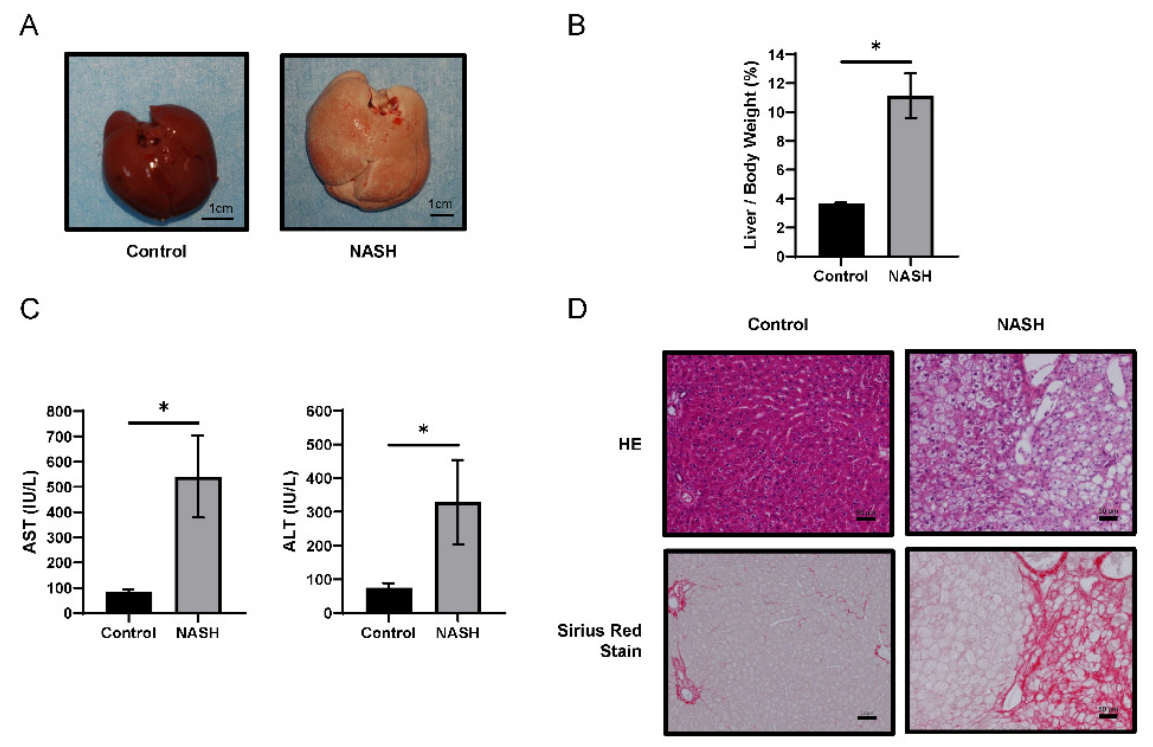
Figure 1. Comparison between SHRSP5/Dmcr rats fed a standard diet (SD) or high-fat and high- cholesterol (HFC) diet for 8 weeks. ( A ) Representative macroscopic appearance of control ( n = 4) and non-alcoholic steatohepatitis (NASH) ( n = 4) livers. Scale bars = 1 cm. ( B ) The liver-to-body weight ratio in each group. ( C ) Aspartate transaminase (AST) and alanine transaminase (ALT) levels in plasma in each group. Values represent mean ± SD. Note: * p < 0.05 vs. control. ( D ) Hematoxylin–eosin- and Sirius Red-stained liver sections. Scale bars = 50 µm.